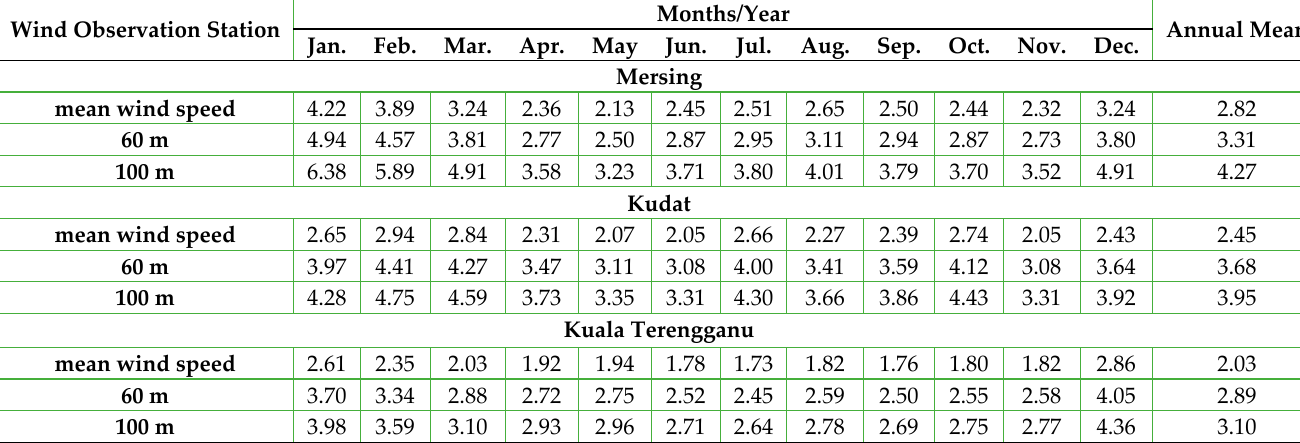
Table 2. Monthly and annual mean wind speed (m / s) in Mersing, Kudat, and Kuala Terengganu at di ff erent heights above ground level. Wind Observation